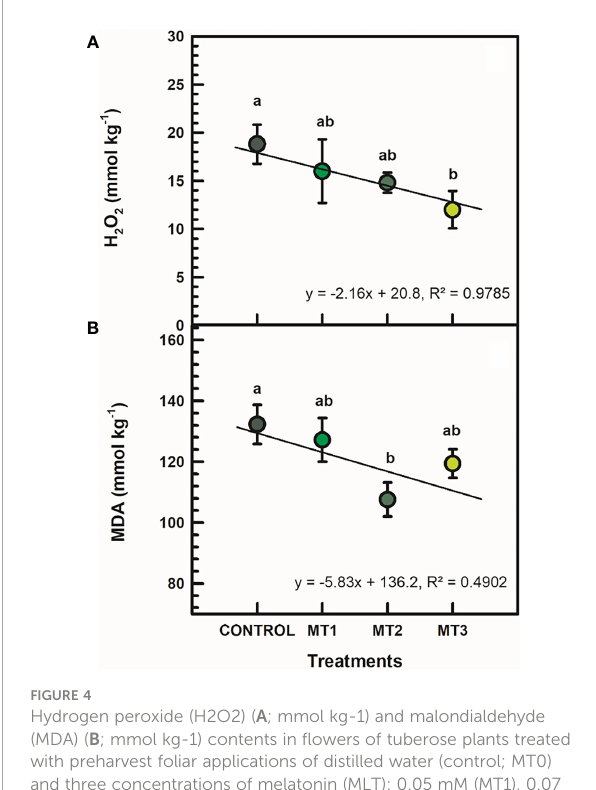
FIGURE 4 Hydrogen peroxide (H2O2) ( A ; mmol kg-1) and malondialdehyde (MDA) ( B ; mmol kg-1) contents in fl owers of tuberose plants treated with preharvest foliar applications of distilled water (control; MT0) and three concentrations of melatonin (MLT): 0.05 mM (MT1), 0.07 mM (MT2), and 1 mM (MT3). Data are means ± SE (n = 40). Different letters above the bars indicate signi fi cant differences according to the LSD test at P =